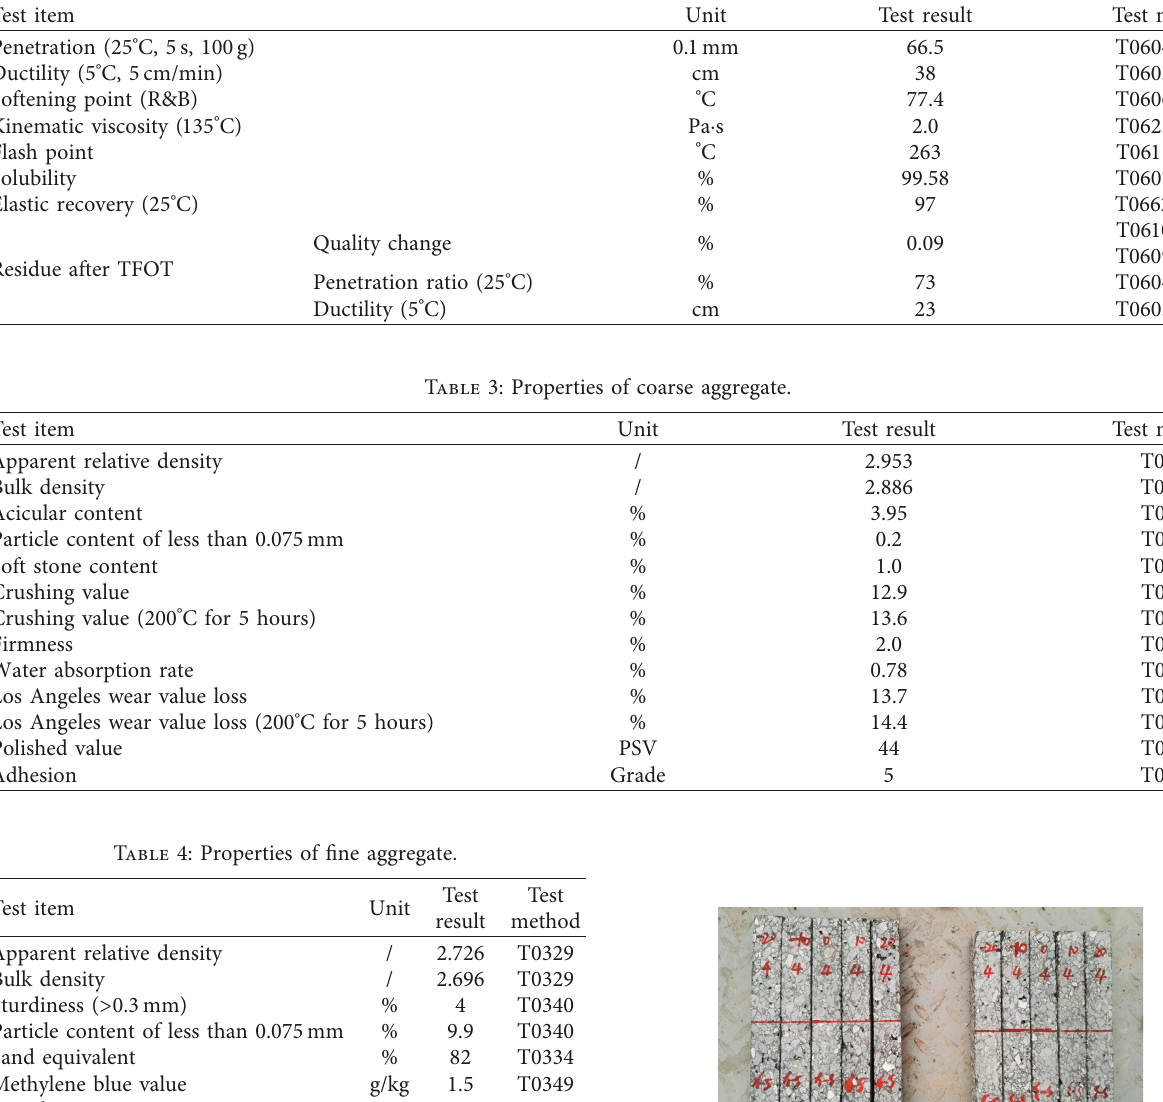
Table 2: Properties of SBS-modified asphalt.